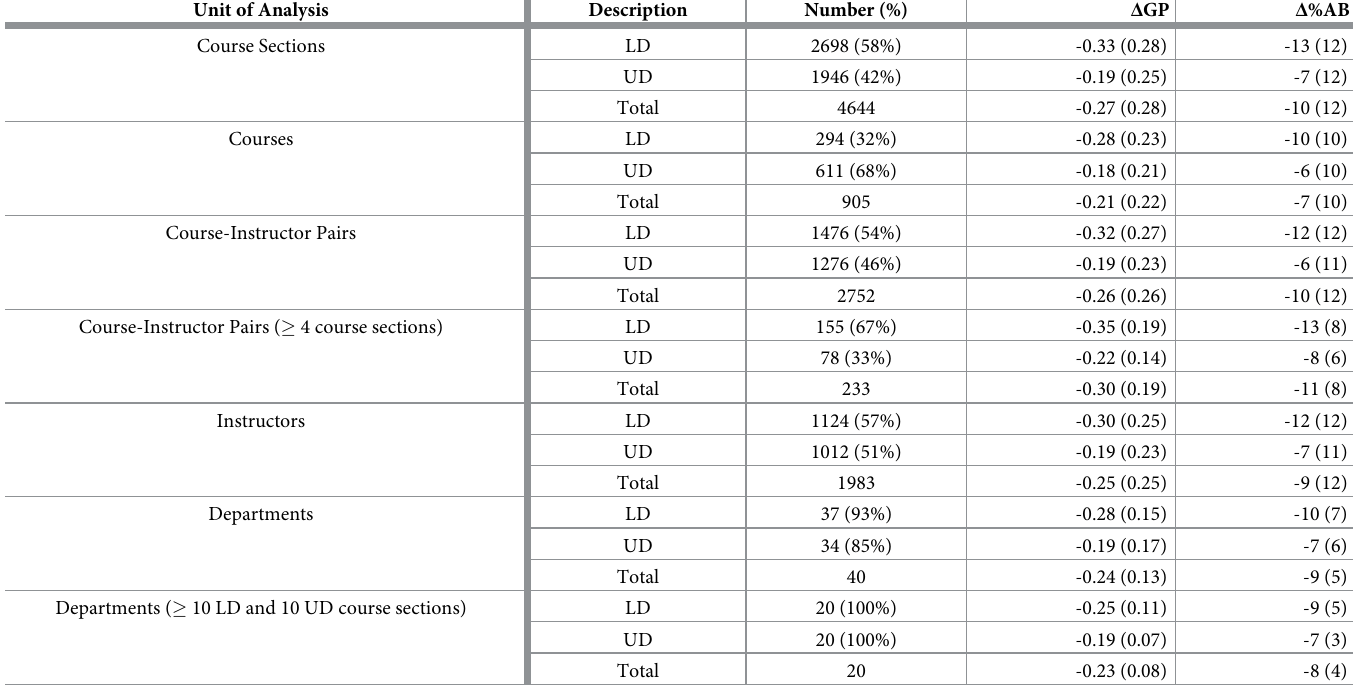
Table 3. The number of lower-division (LD) and upper-division (UD) course sections, courses, course-instructor pairs, and departments as well as the respective summary statistics for racial opportunity